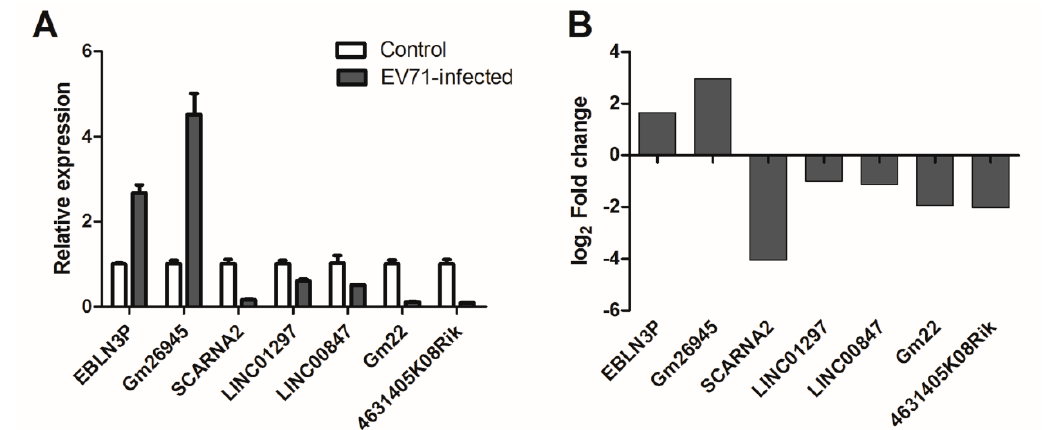
Figure 8. Comparisons of qPCR with RNA-seq results. ( A ) The validation results of qPCR. ( B ) The primary results of RNA-seq.